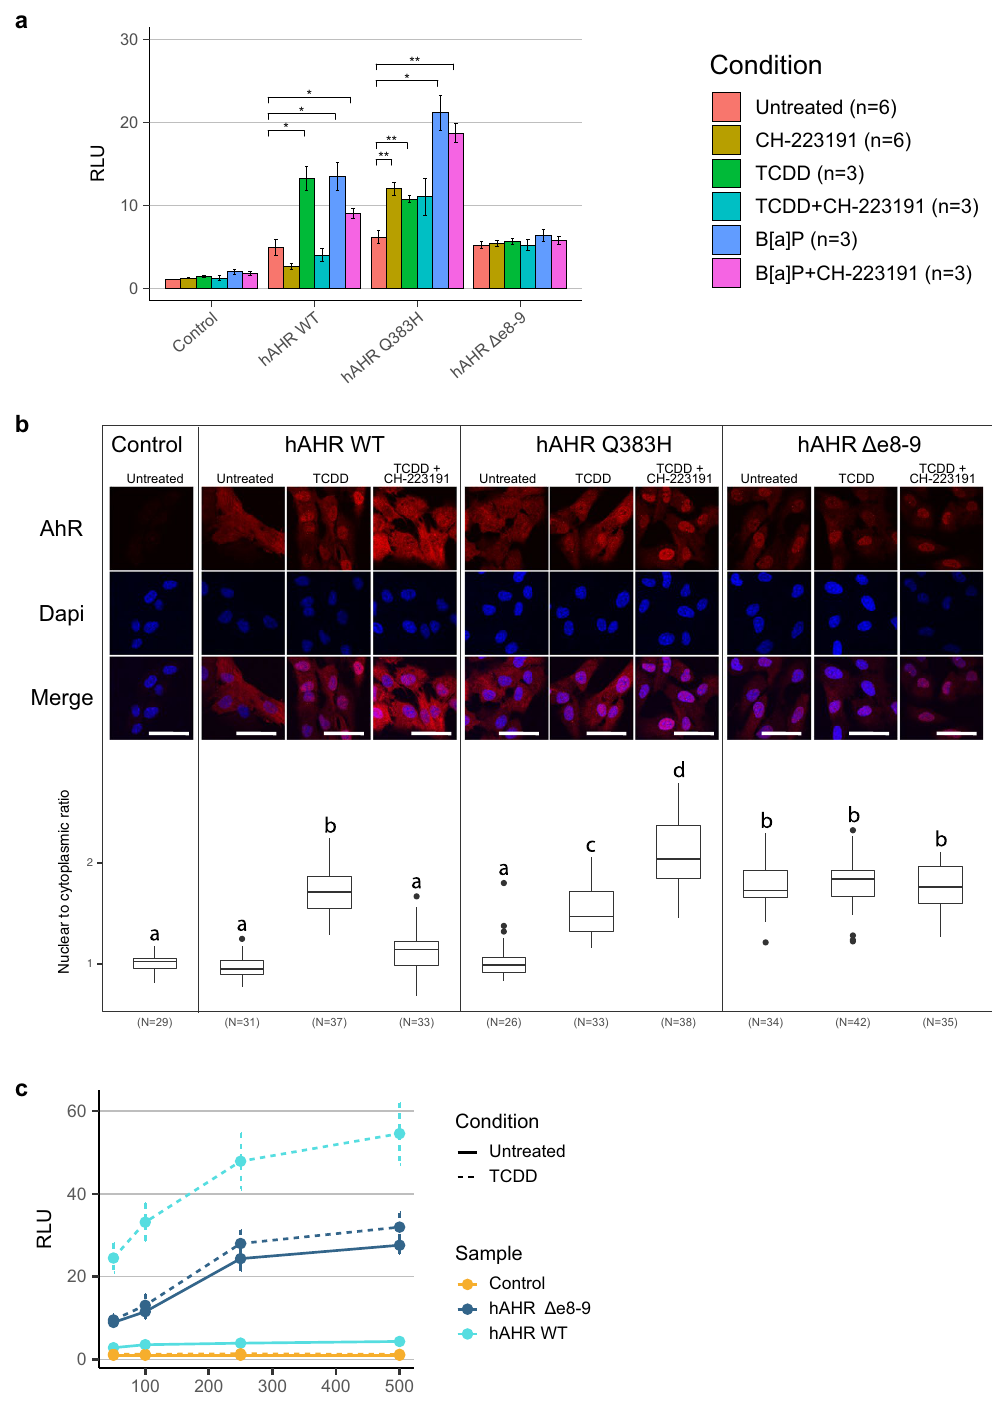
Figure 2. Altered protein localization and transcriptional activation of hAHR mutants. ( a ) Luciferase reporter assay of HEK293T cells transiently transfected with empty control, hAHR WT , hAHR Q383H , or hAHR Δe8-9 vectors together with XRE- luciferase reporter construct. Assays were performed with different AHR ligands (TCDD and B[a]P) and AHR antagonist (CH-223191) conditions. Significance was calculated with Student’s T-test for stimulated versus untreated condition per construct. * p < 0.05, ** p < 0.01. RLU = relative luciferase unit. ( b ) Immunofluorescence of RPE1 cells that constitutively express hAHR WT , hAHR Q383H , or hAHR Δe8-9 were incubated for 4 h with TCDD or CH-223191. AHR was detected with immunofluorescence (red) and DNA with Dapi (blue). Scale bar = 50 μm. The boxplots present the ratio of nuclear to cytoplasmic signal of AHR expression for all individual captured cells. Transgene free cells served as negative controls (left panels). Lowercase letters indicate significant differences between treatments ( p < 0.05, Anova). ( c ) Luciferase reporter assay of HEK293T cells transiently transfected with increasing concentration of hAHR WT , hAHR Δe8-9 , and empty control vectors (n = 4 per data